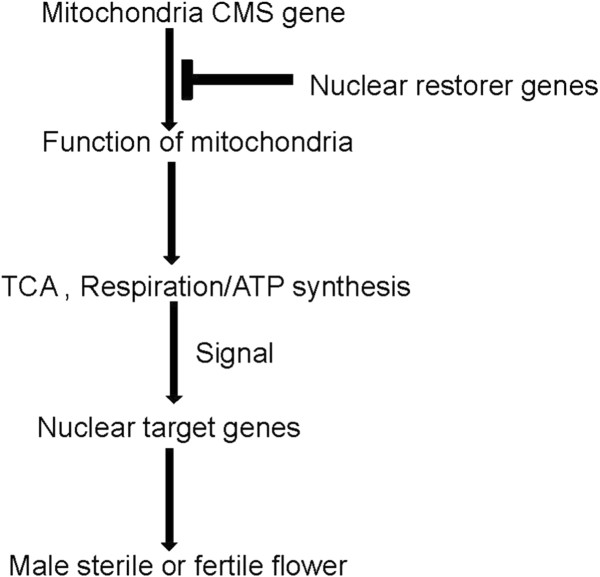
Overview of CMS in sterile plants and fertility restoration in fertile plants. Expression of mitochondrial CMS genes led to dysfunction of mitochondria. Products of nuclear restorer genes suppressed the effects of CMS genes. The state of the mitochondria was signaled to nuclear target genes and resulted in male sterile or fertile flower.